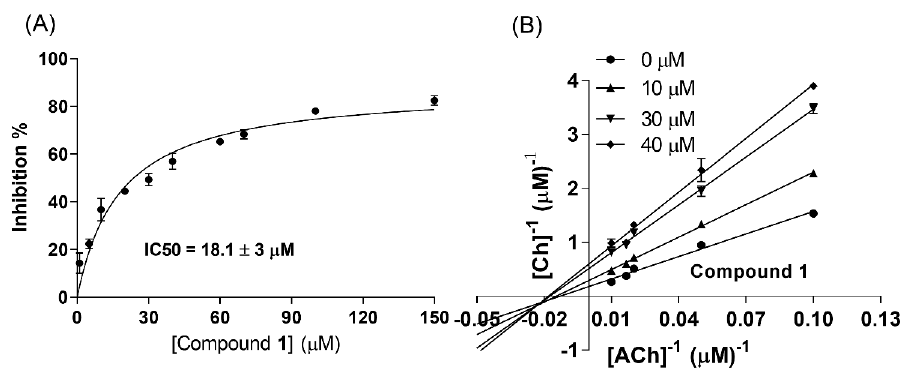
Figure 3. Dose-response inhibition curve ( A ) and Lineweaver−Burk reciprocal plots ( B ) for com- pound 1 BChE hu -ICER using the on-flow dual parallel enzyme assay. Results obtained from three independent experiments (n = 3) expressed by mean ± SEM.